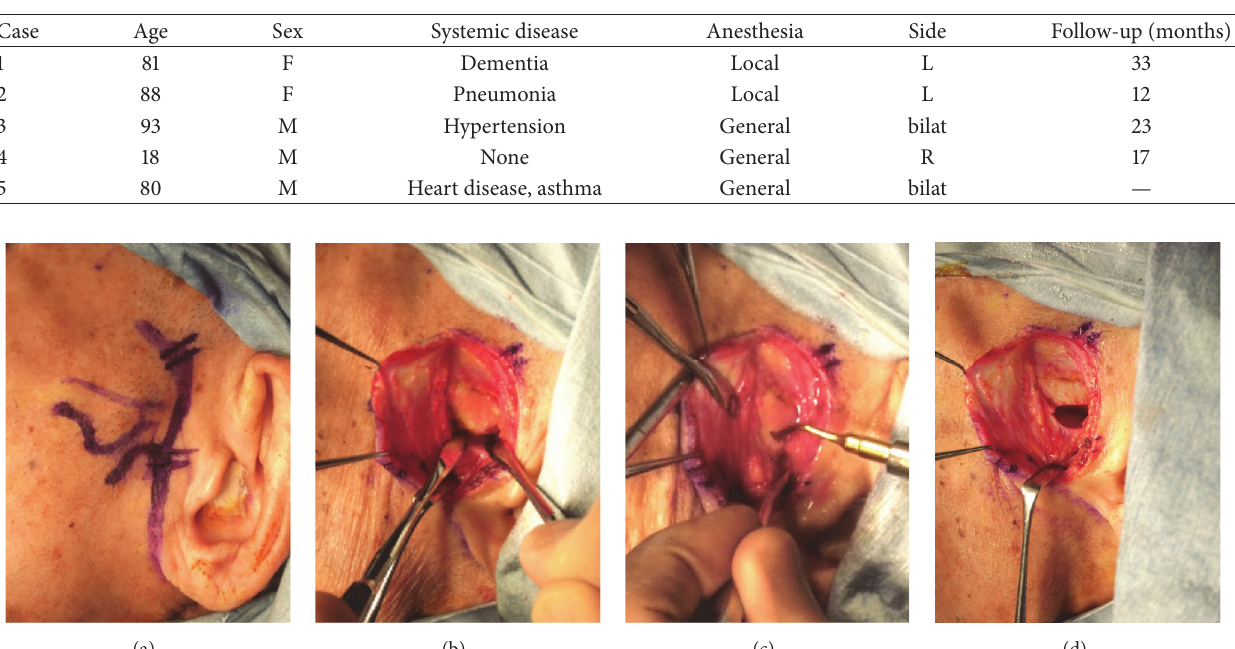
Figure 1: Eminectomy of the left temporomandibular joint. (a) Skin incision line. (b) Inside the TMJ capsule. (c) Incision of the eminence. (d) Following bone